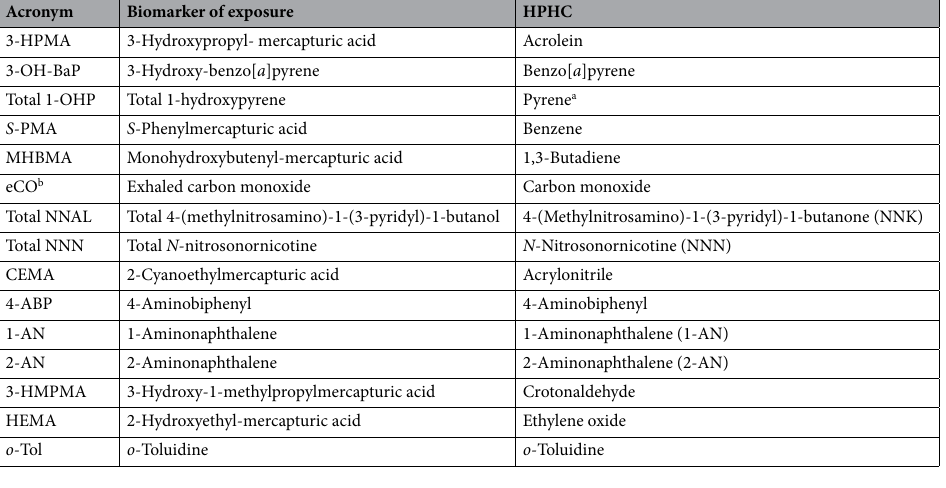
Table 2. Biomarkers of exposure to selected harmful and potentially harmful constituents. a Although pyrene is not listed as an HPHC by the FDA, the BoE to pyrene was assessed as an alternative and supportive BoE to benzo[ a ]pyrene 20 . b The exhaled CO level of subjects was measured by using a piCO